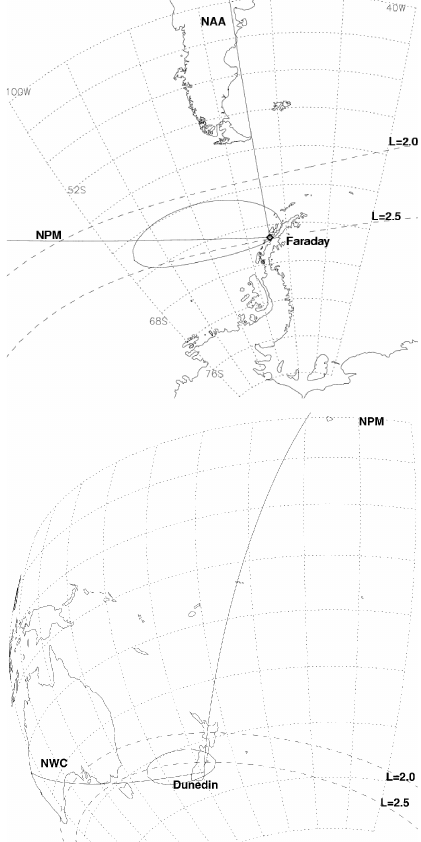
Fig. 2. Maps showing the VLF paths for Trimpi observations un- dertaken in this study, along with the L =2.0 and L =2.5 contours at 100km altitude. An ellipse marks the WEP modified ionospheric region used in our calculations. Top Panel: the region around the Antarctic Peninsula and the location of Faraday Station. Bottom Panel: the region around New Zealand and the location of